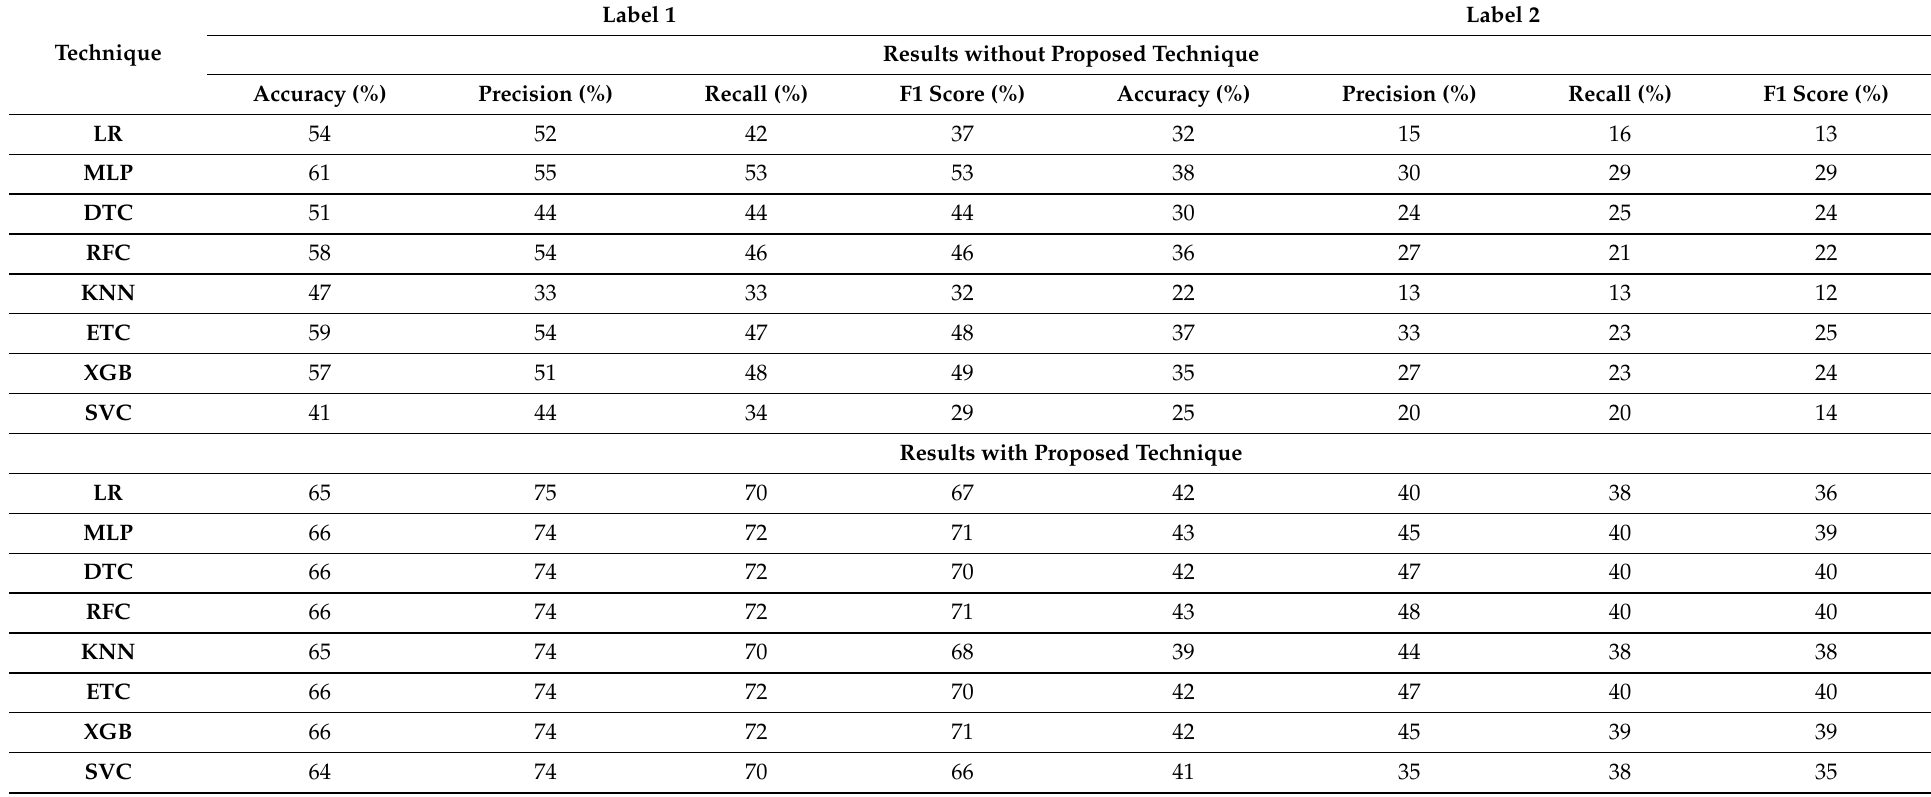
Table 8. Performance comparative analysis of models using an imbalanced dataset and 85:15